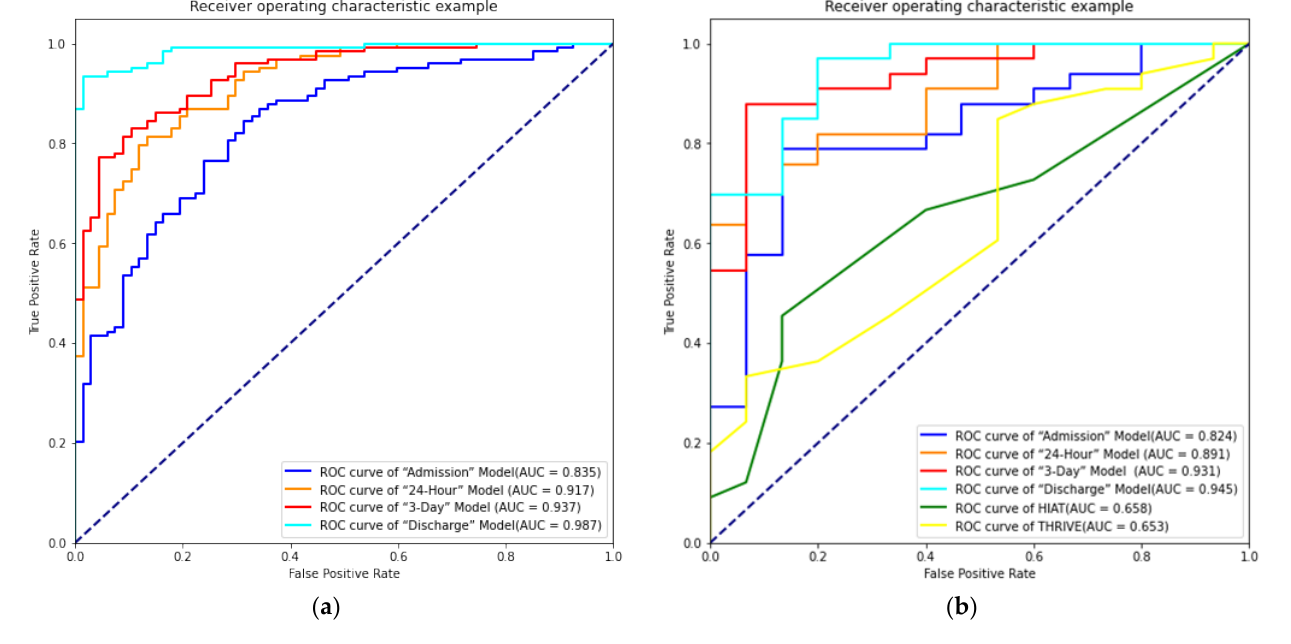
Figure 1. ( a ) The receiver operating characteristic curve (ROC) of four models on the training set; ( b ) the receiver operating characteristic curve (ROC) of four models and traditional scores on testing set. AUC, the area under curve; THRIVE, Totaled Health Risks in Vascular Events; HIAT, Houston Intra-arterial Recanalization Therapy.